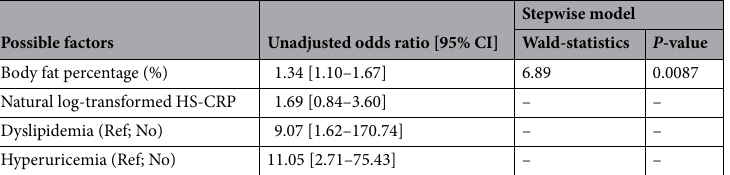
Table 3. Results of the forward–backward stepwise selection procedure for the low IGF-1 group a . HS-CRP high-sensitivity C-reactive protein. a Forward-backward stepwise variable selection procedure was conducted with clinical parameters with P-value < 0.05 as the statistical significance entry